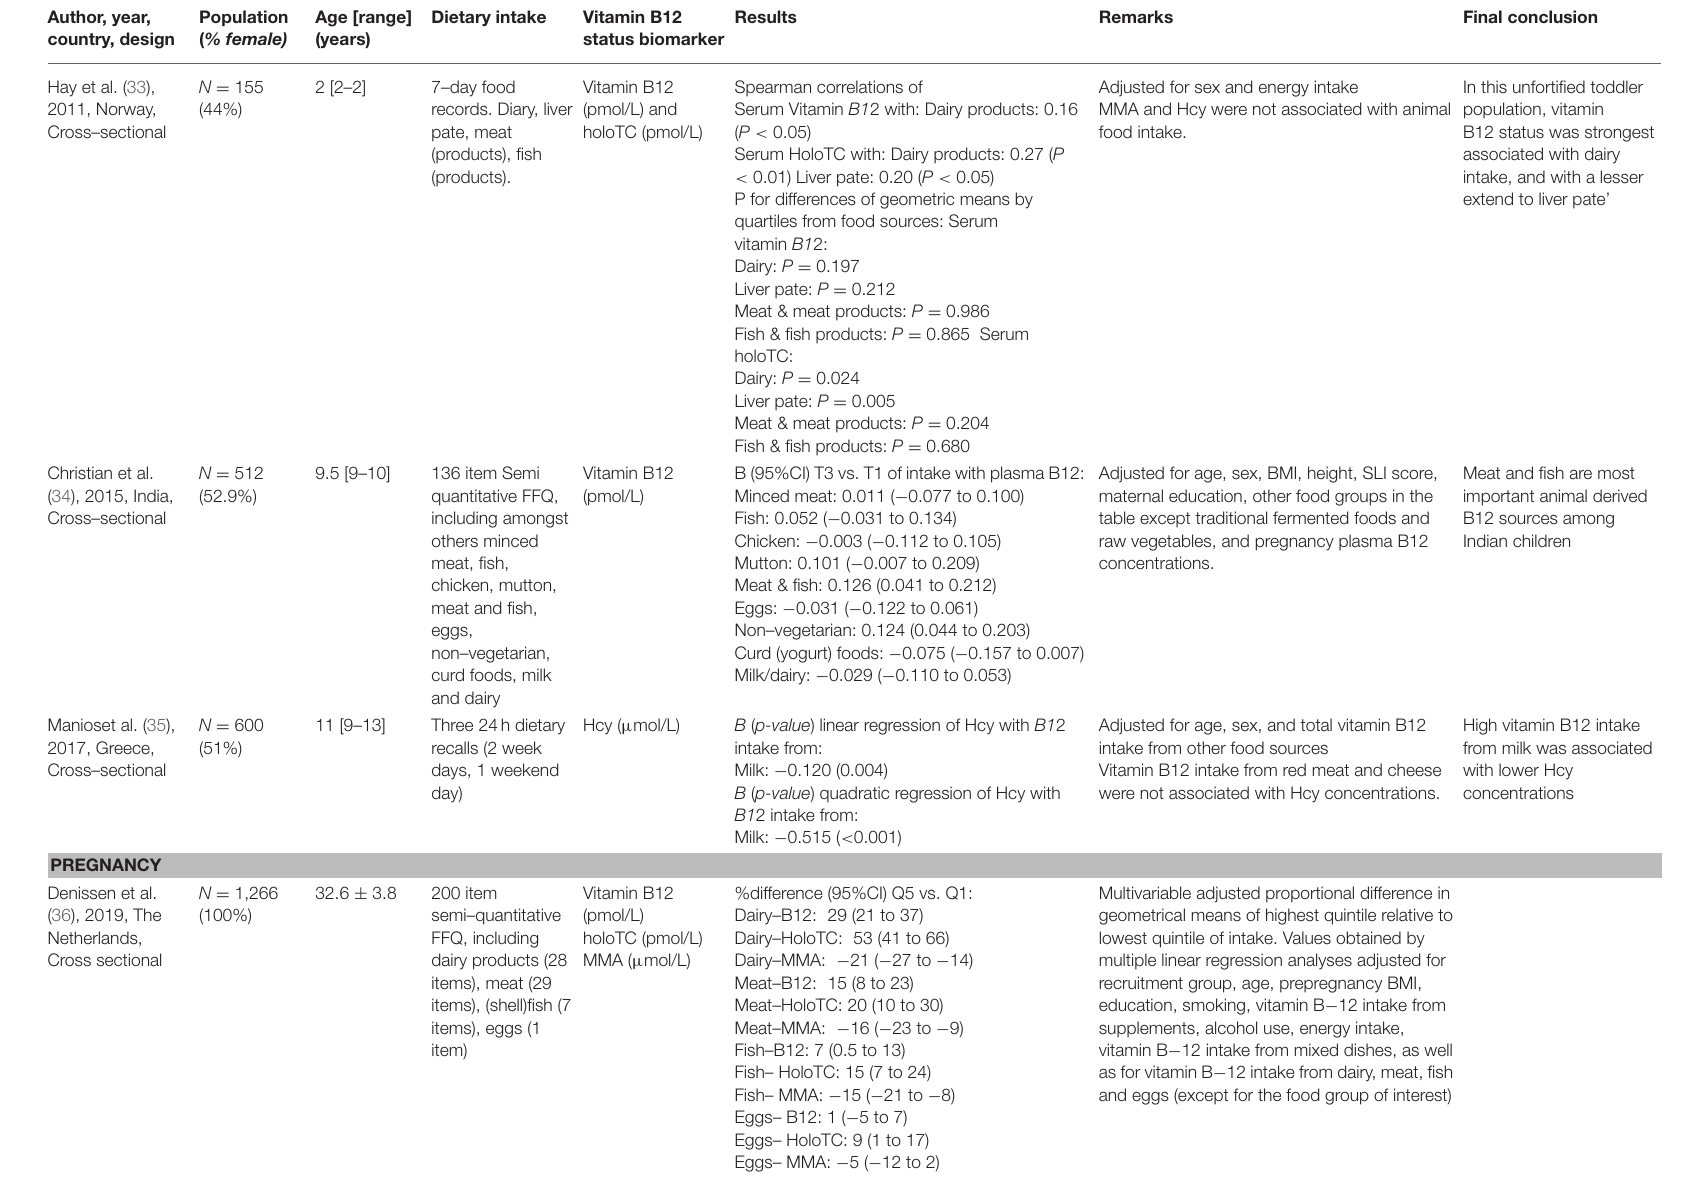
Spearman correlations of Serum Vitamin B1 2 with: Dairy products: